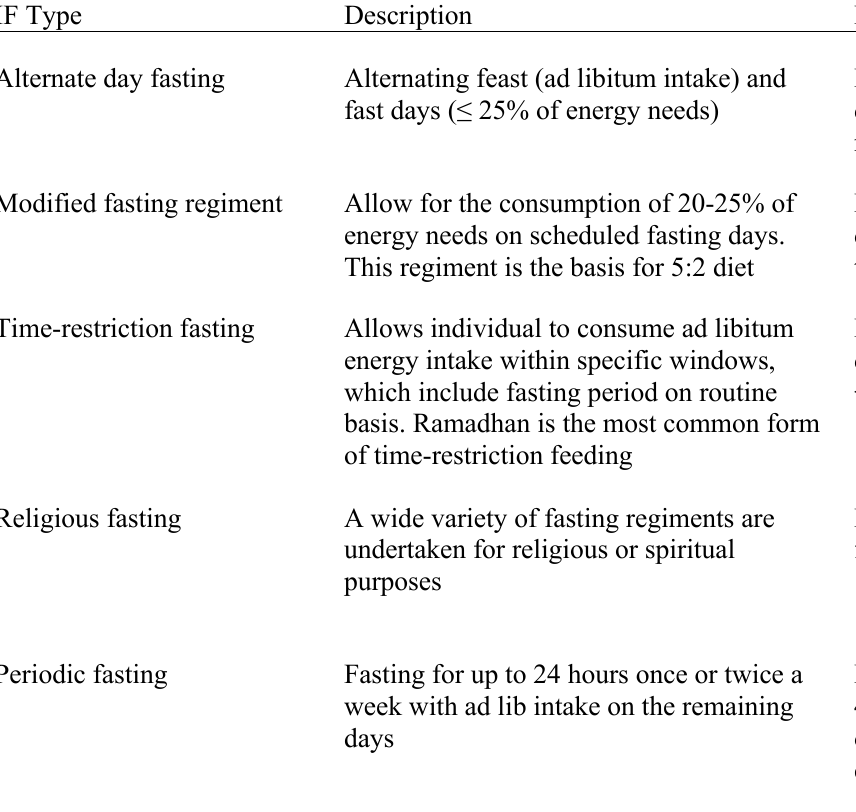
Table 1 . Type of intermittent